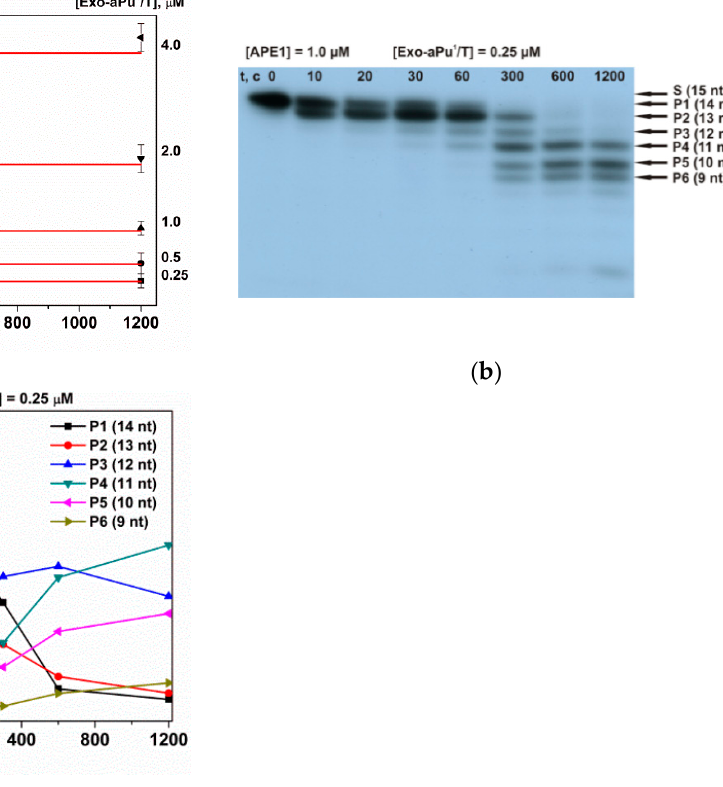
placement of a 3 (cid:48) nucleotide in the enzyme’s active site. The second step in this mechanism could